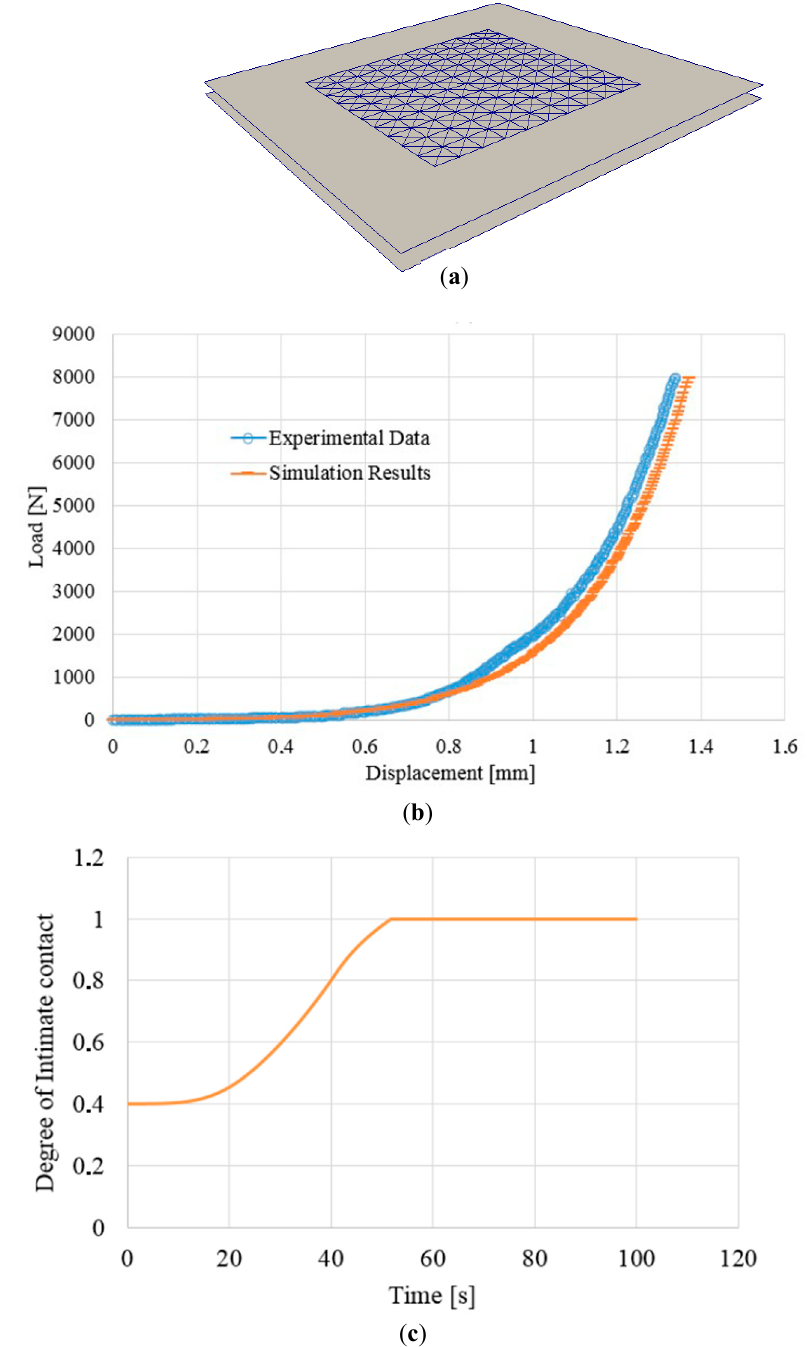
Figure 9. Simulation of a compaction test at 300 ◦ C. ( a ) Meshed structure (composite blank in the middle); ( b ) Simulated and experimental load versus displacement curves; ( c ) Evolution of the degree of intimate contact during the